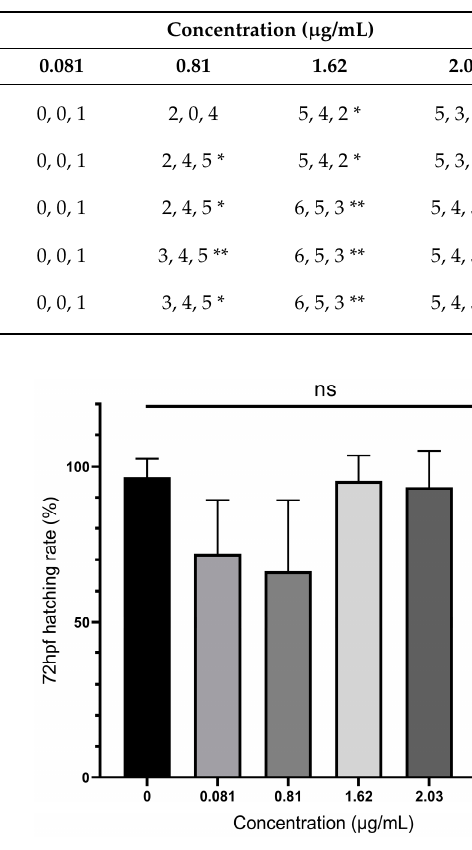
Figure 3. The hatching rate of zebrafish embryos exposed to AMs for each observation time. Hatching rate was calculated with the equation (number of hatched individuals)/(survival individuals of one replicate) and represented as the mean ± SD (n = 3). Tukey’s multiple comparison test and one- way ANOVA were used to examine the results of the experiments. NS was regarded as having no signi fi cant di ff erence.